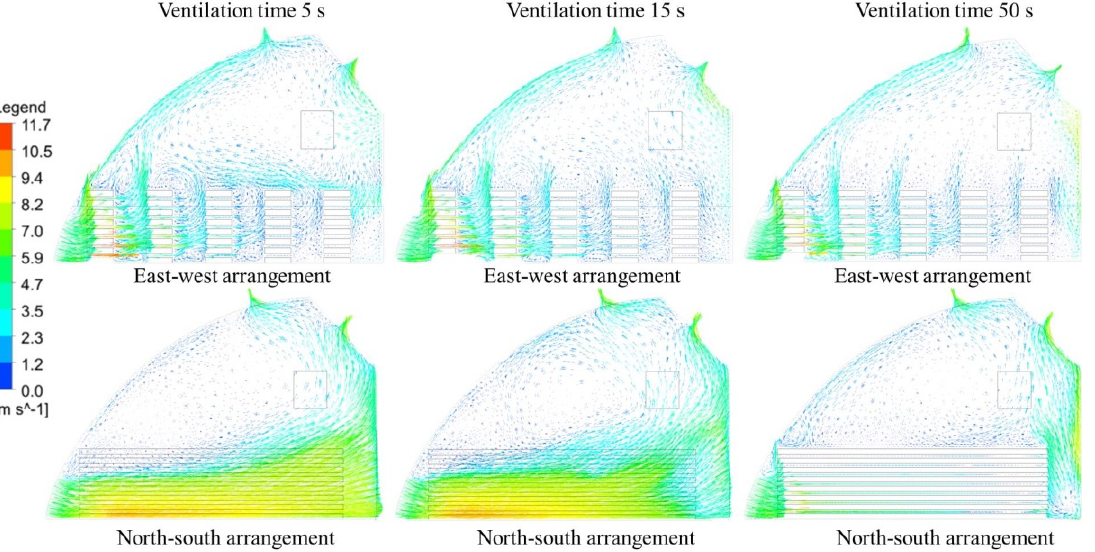
9 of 18 Figure 6. Velocity magnitudes of typical horizontal cross sections under different arrangements of cultivation racks. The speed vectors under the two modes were analyzed, and the numerical simula- tion results are illustrated in Figure 7. Due to the blocking effect of the east-west cultiva- tion racks in the front row, the fresh air from outside cannot be smoothly blown to the